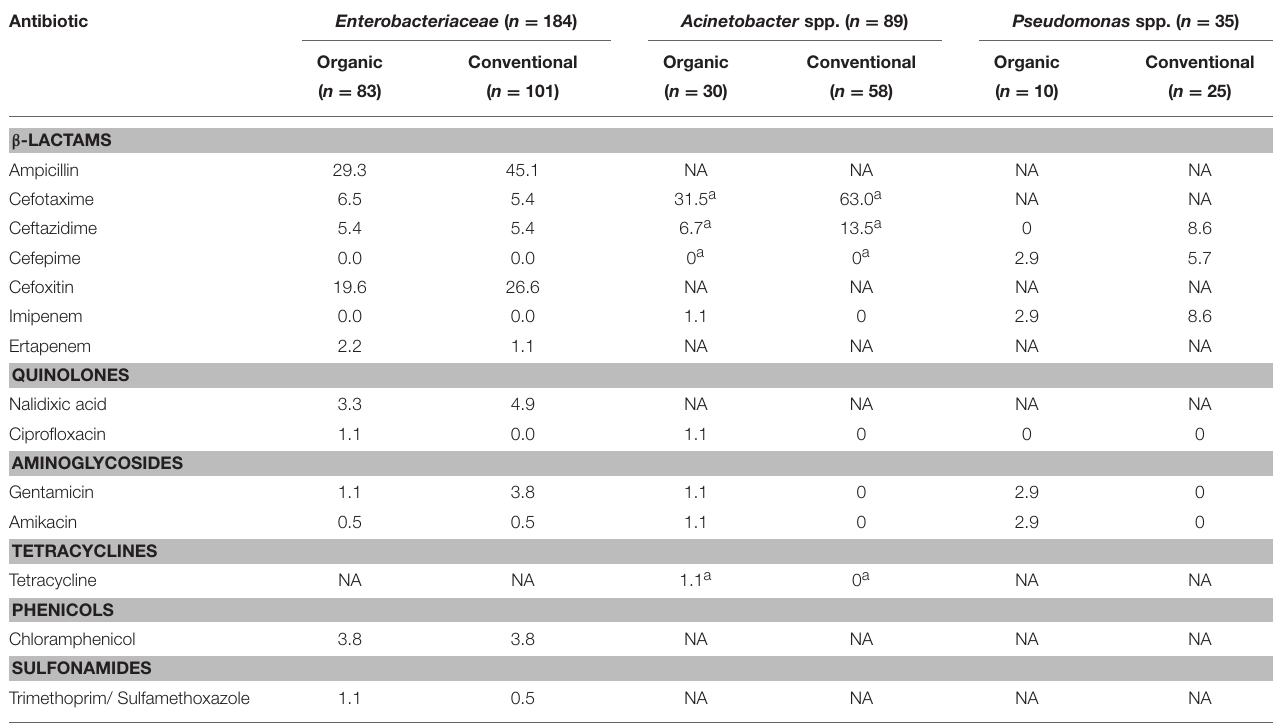
TABLE 2 | Percentage of isolates from organic and conventionally produced fruits and vegetables non-susceptible to antibiotics according with their family ( n = 308). Antibiotic Enterobacteriaceae ( n = 184)